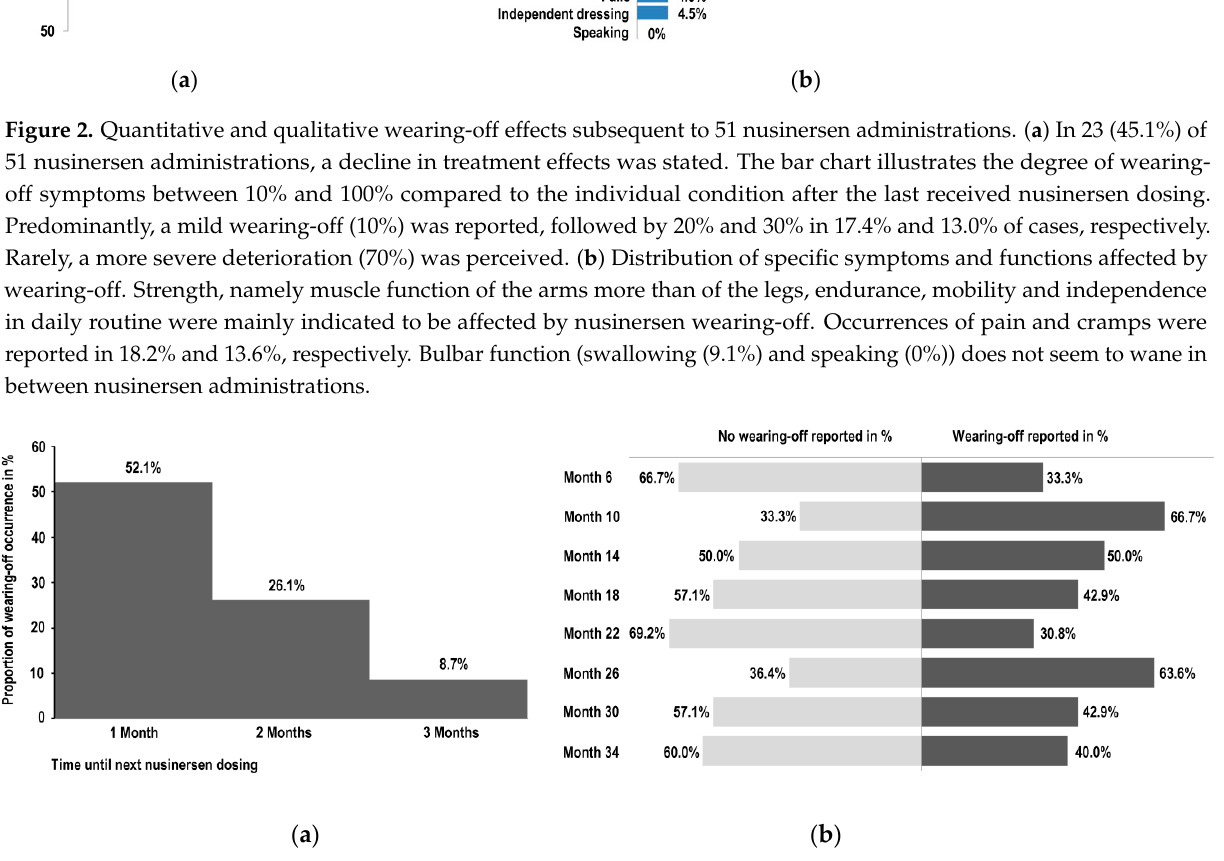
Figure 3. Assessment of time-dependency of nusinersen wearing-off subsequent to 51 nusinersen administrations. ( a ) The bar chart indicates the reported period prior to the next nusinersen dosing when symptoms or functions started to wane ( n = 23). The last month before the next nusinersen administration was particularly at risk of wearing-off effects, confirming a time dependency. ( b ) Wearing-off phenomena were reported almost consistently during the treatment course. The displayed bar chart shows the ratio of reported wearing-off events (dark bar to the right) and no wearing-off phenomenon reported (light bar to the left) related to nusinersen treatment time points during maintenance dosing.